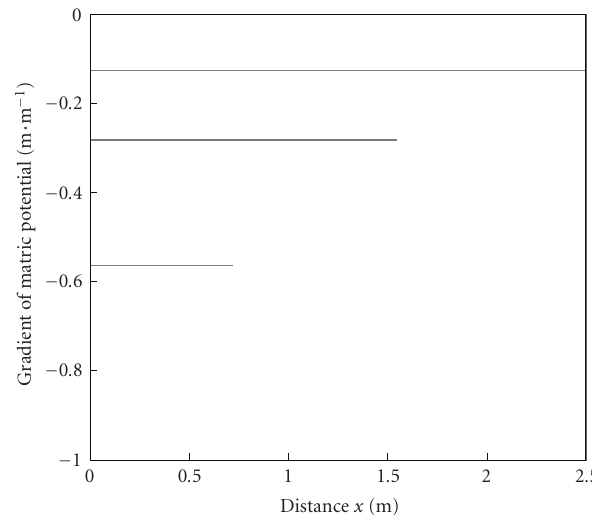
Figure 4: Matric gradient as a function of x inside the soil for times t 1 , t 2 , and t 3 equal to 15, 60, and 300 min (from down to up), according to (50a) or